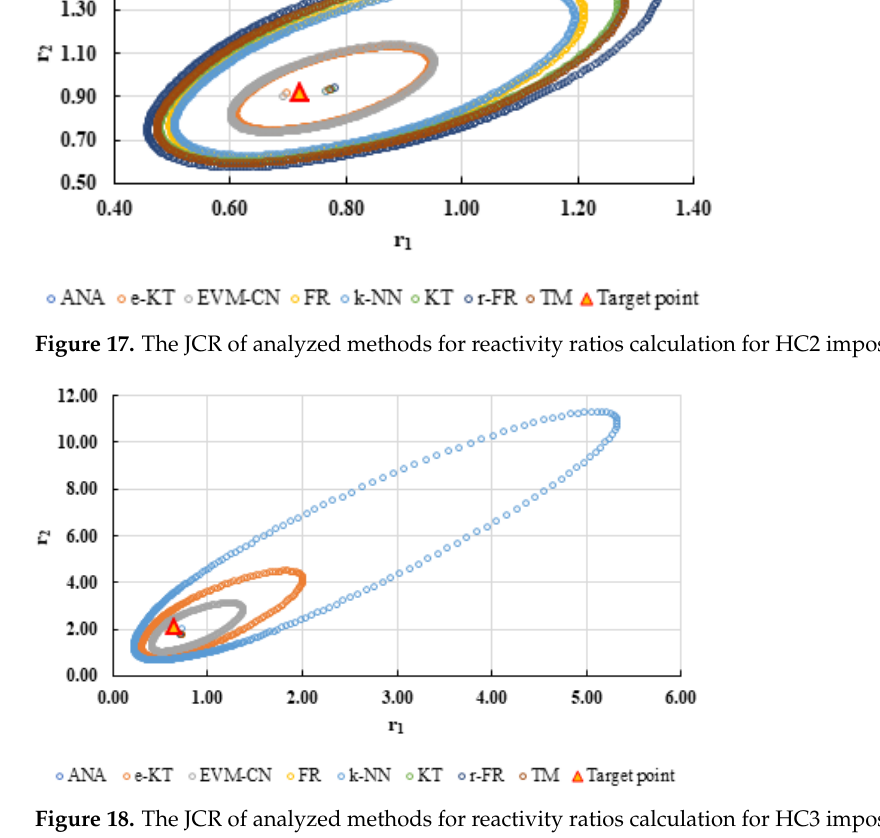
Table 21. The reactivity ratios obtained for copolymerization of NPEA-NVP [39].